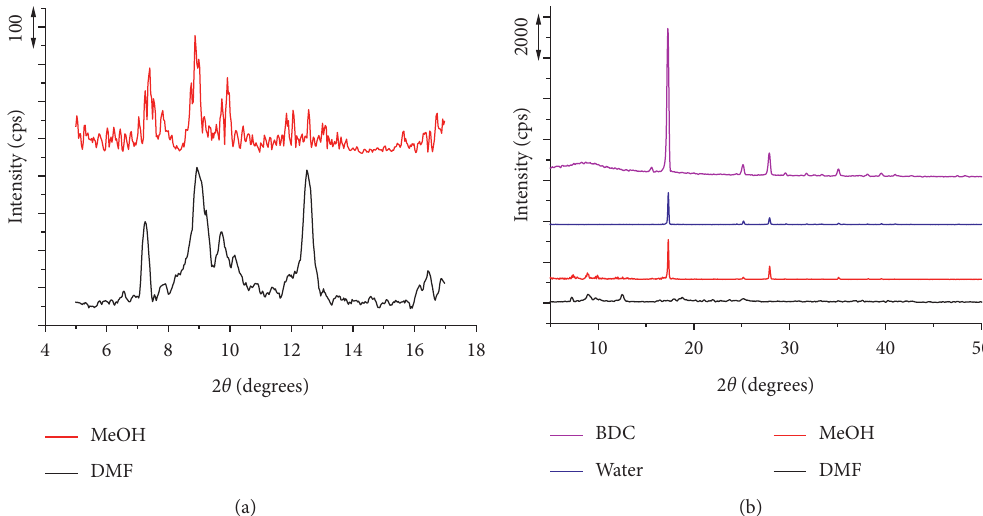
Figure 1: XRD patterns of iron (III) benzene dicarboxylate samples: (a) synthesis in MeOH and DMF (small angle); (b) synthesis in different solvents (the BDC sample for comparison).